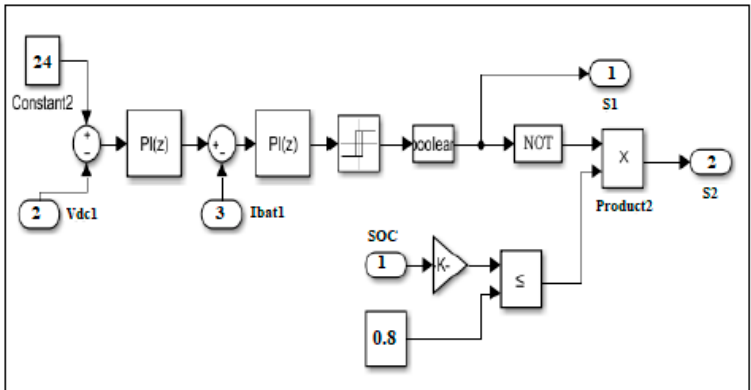
Figure 7. Simulink model of battery control.